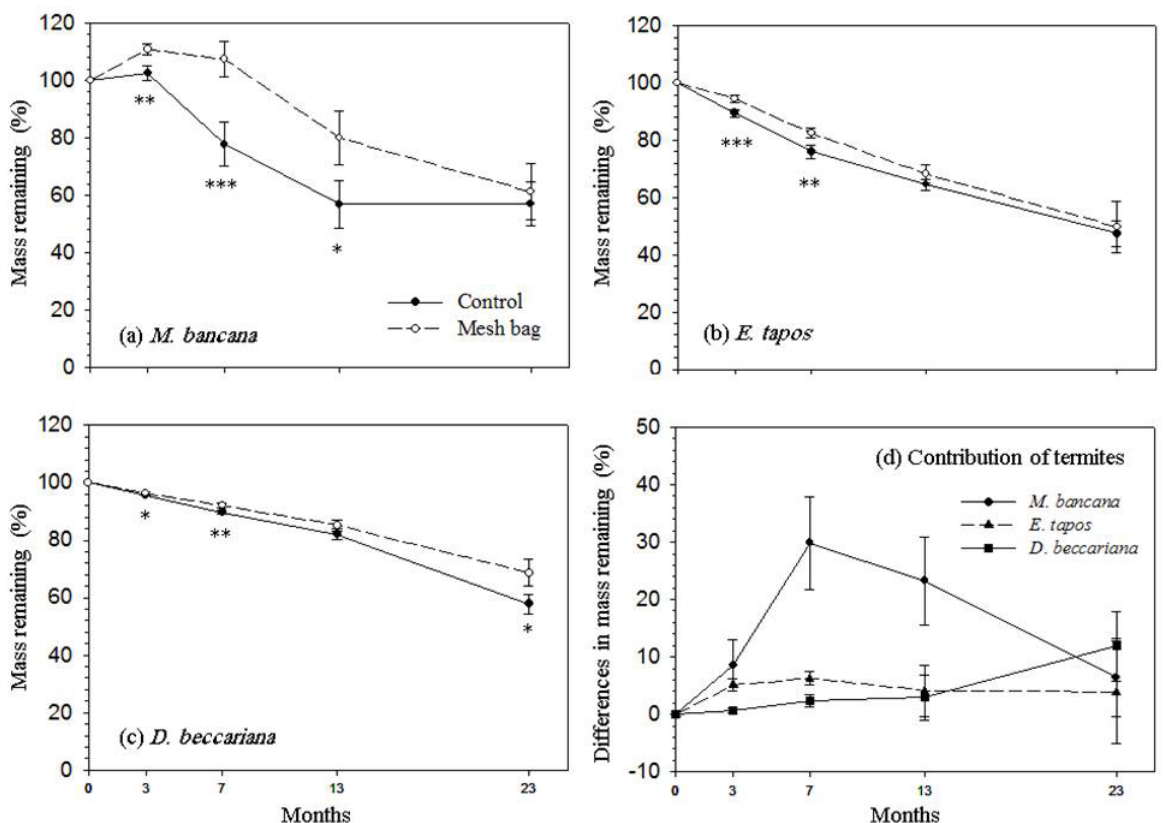
Fig 3. Mean mass remaining for (a) M. bancana , (b) E. tapos , and (c) D. beccariana , and (d) the contribution of termites during the 23 months. Contribution of termites = Differences in mass remaining between treatments. Vertical bars represent the standard error. Asterisks indicate significant differences (*p < 0.1, ** p < 0.05, *** p <